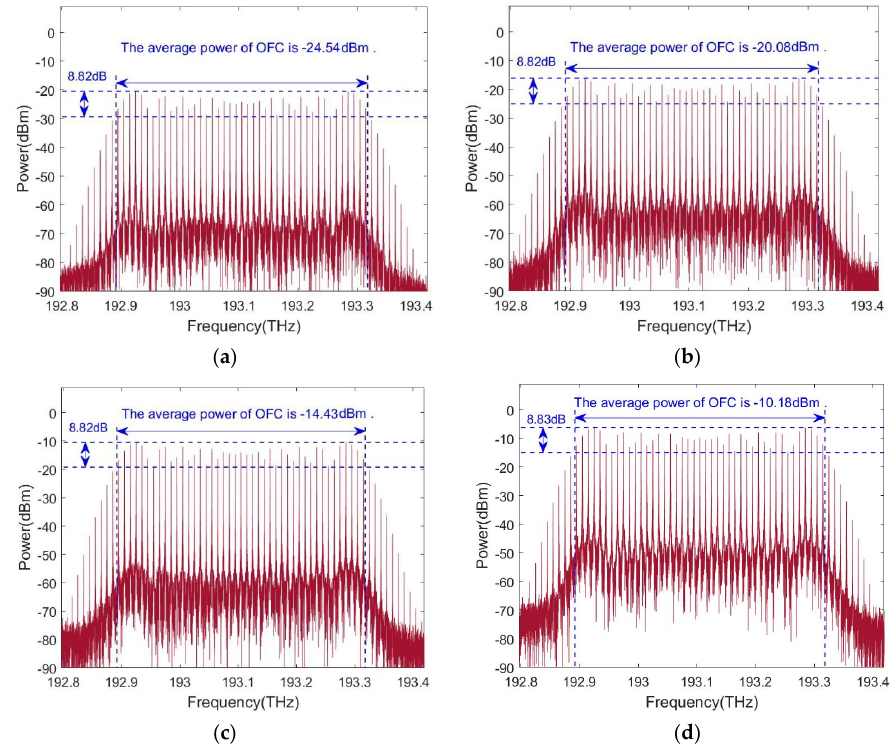
Figure 5. The optical spectra of OFC for different input optical powers: ( a ) 15 dBm, ( b ) 20 dBm, ( c ) 25 dBm, and ( d ) 30 dBm.